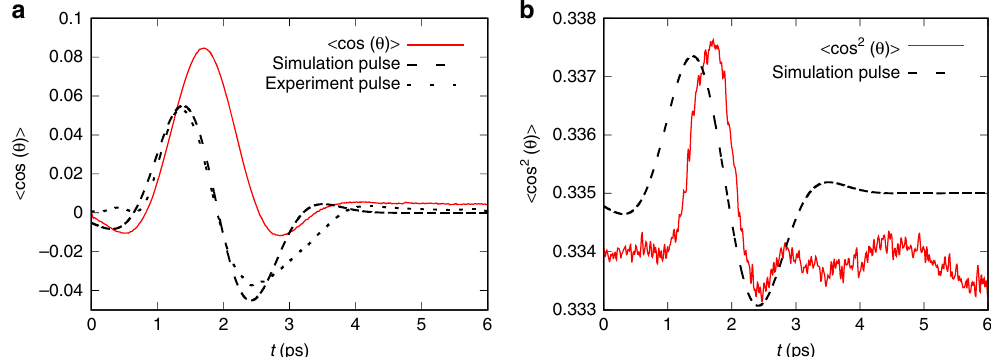
Fig. 2 MD simulation of the THz Kerr effect in water. Value of ( a ) 〈 cos ( θ ) 〉 ( t ) and b 〈 cos 2 ( θ ) 〉 ( t ) during the non-equilibrium MD simulation of water. For comparison, the THz pump pulse pro fi les employed in the experiment and the simulations are shown as black dashed and dotted lines, respectively. θ is the angle of the water dipoles with respect to the fi eld polarization u z . ¼ h